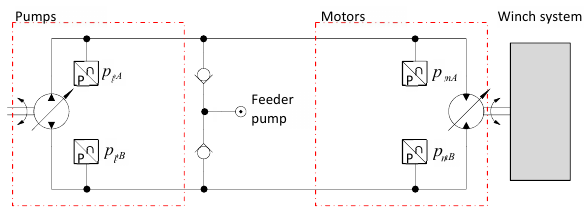
Figure 5: Simplified diagram of the investigated closed loop winch